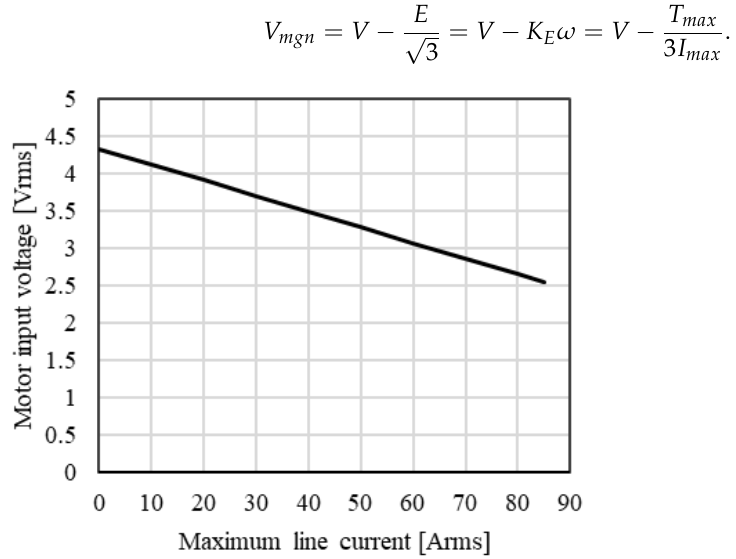
Figure 7. Motor input voltage.